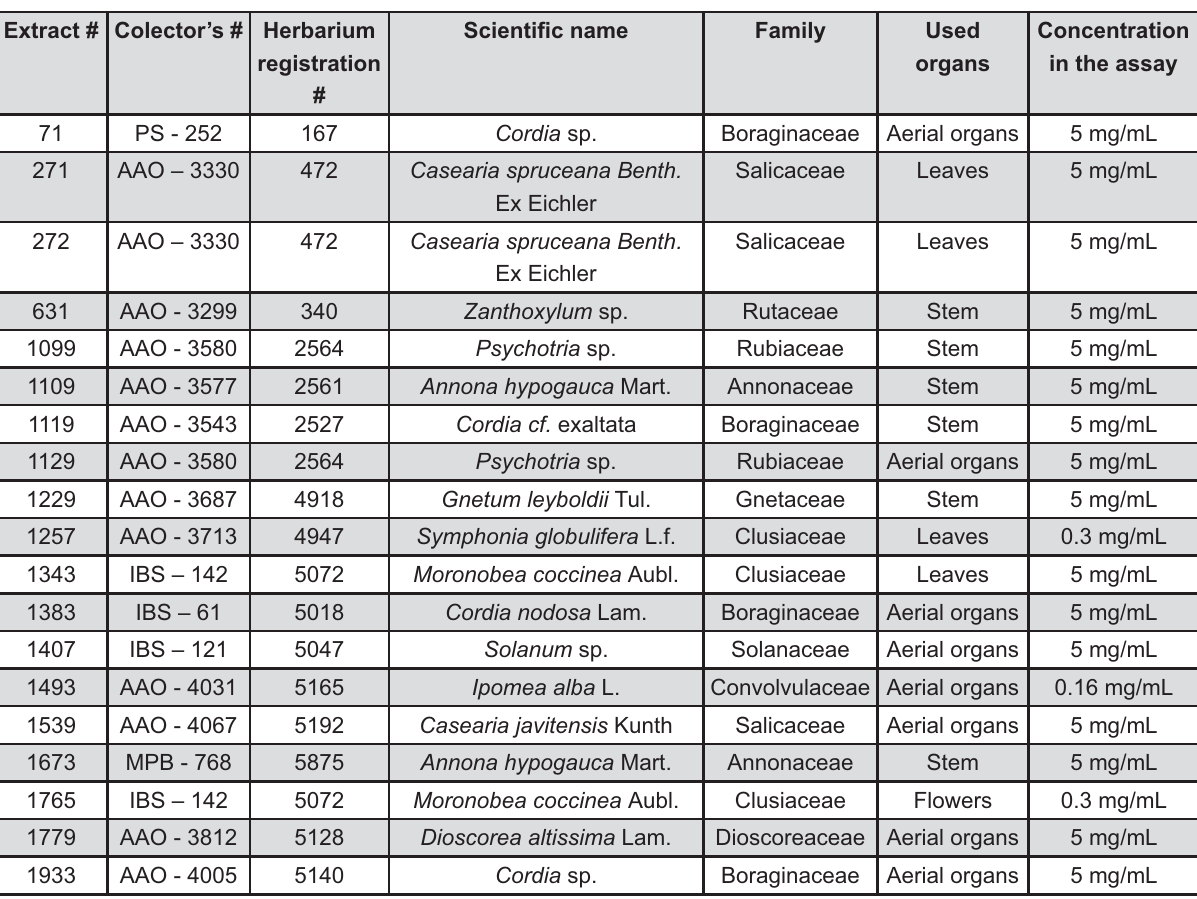
Figure 1- Botanical data for the plants used to obtain organic (odd numbers) or aqueous (even numbers) extracts and